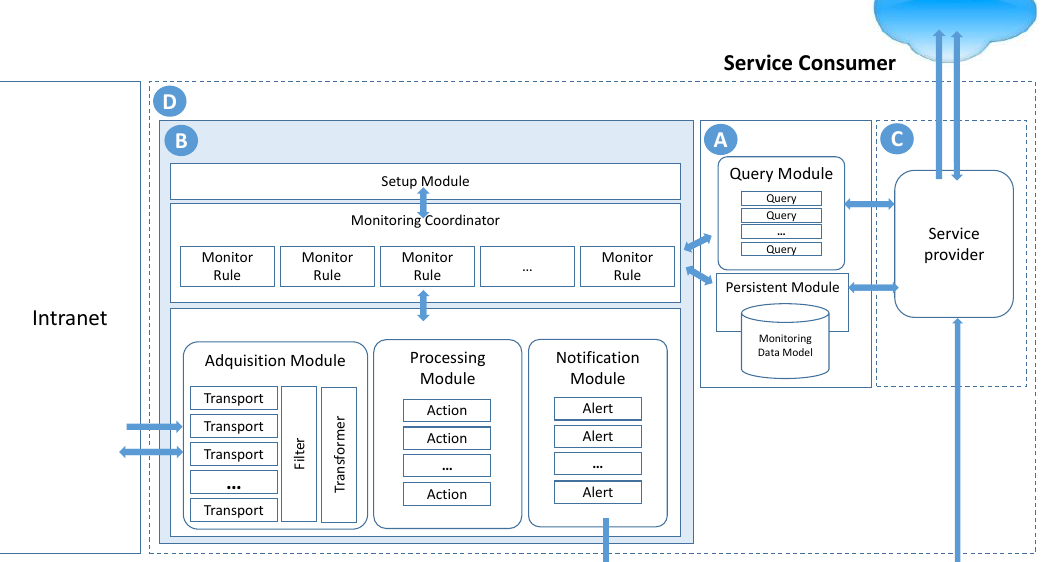
Figure 3. Functional monitoring architectural model.